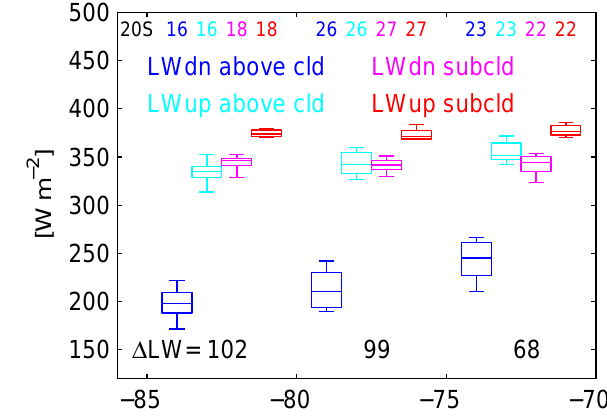
Fig. 16. 20 ◦ S leg-mean rain rate boxplots: at cloud base, de- rived from column-max reflectivity and cloud base Z − R (black), at 500m, from reflectivity and cloud base Z − R (green), at 100m, from reflectivity and surface Z − R (pink), on in-cloud legs (blue) and sub-cloud legs (red), from 2D-C raindrop size distribution). Colored dots show the mean over all legs in each longitude bin.